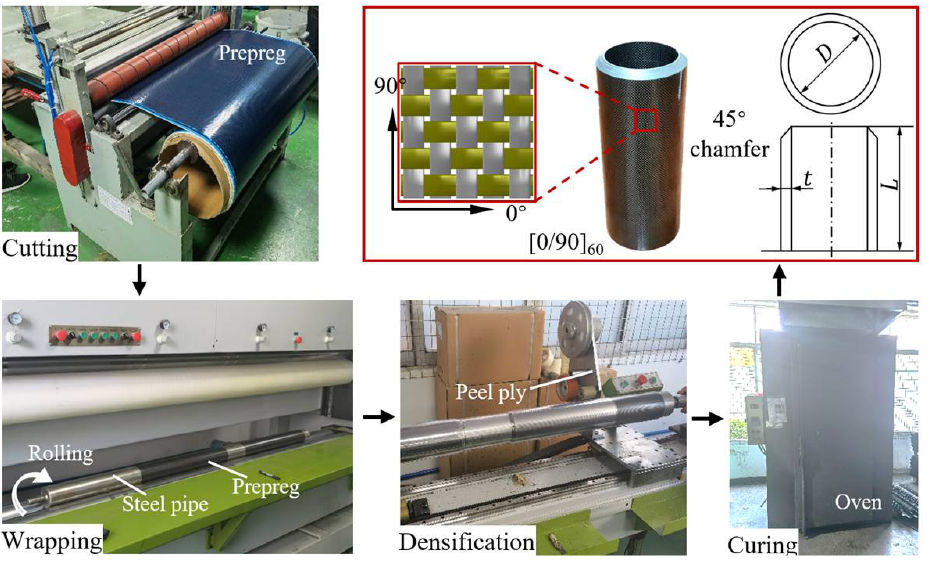
Figure 1. Fabrication process of circular CFRP tubes.